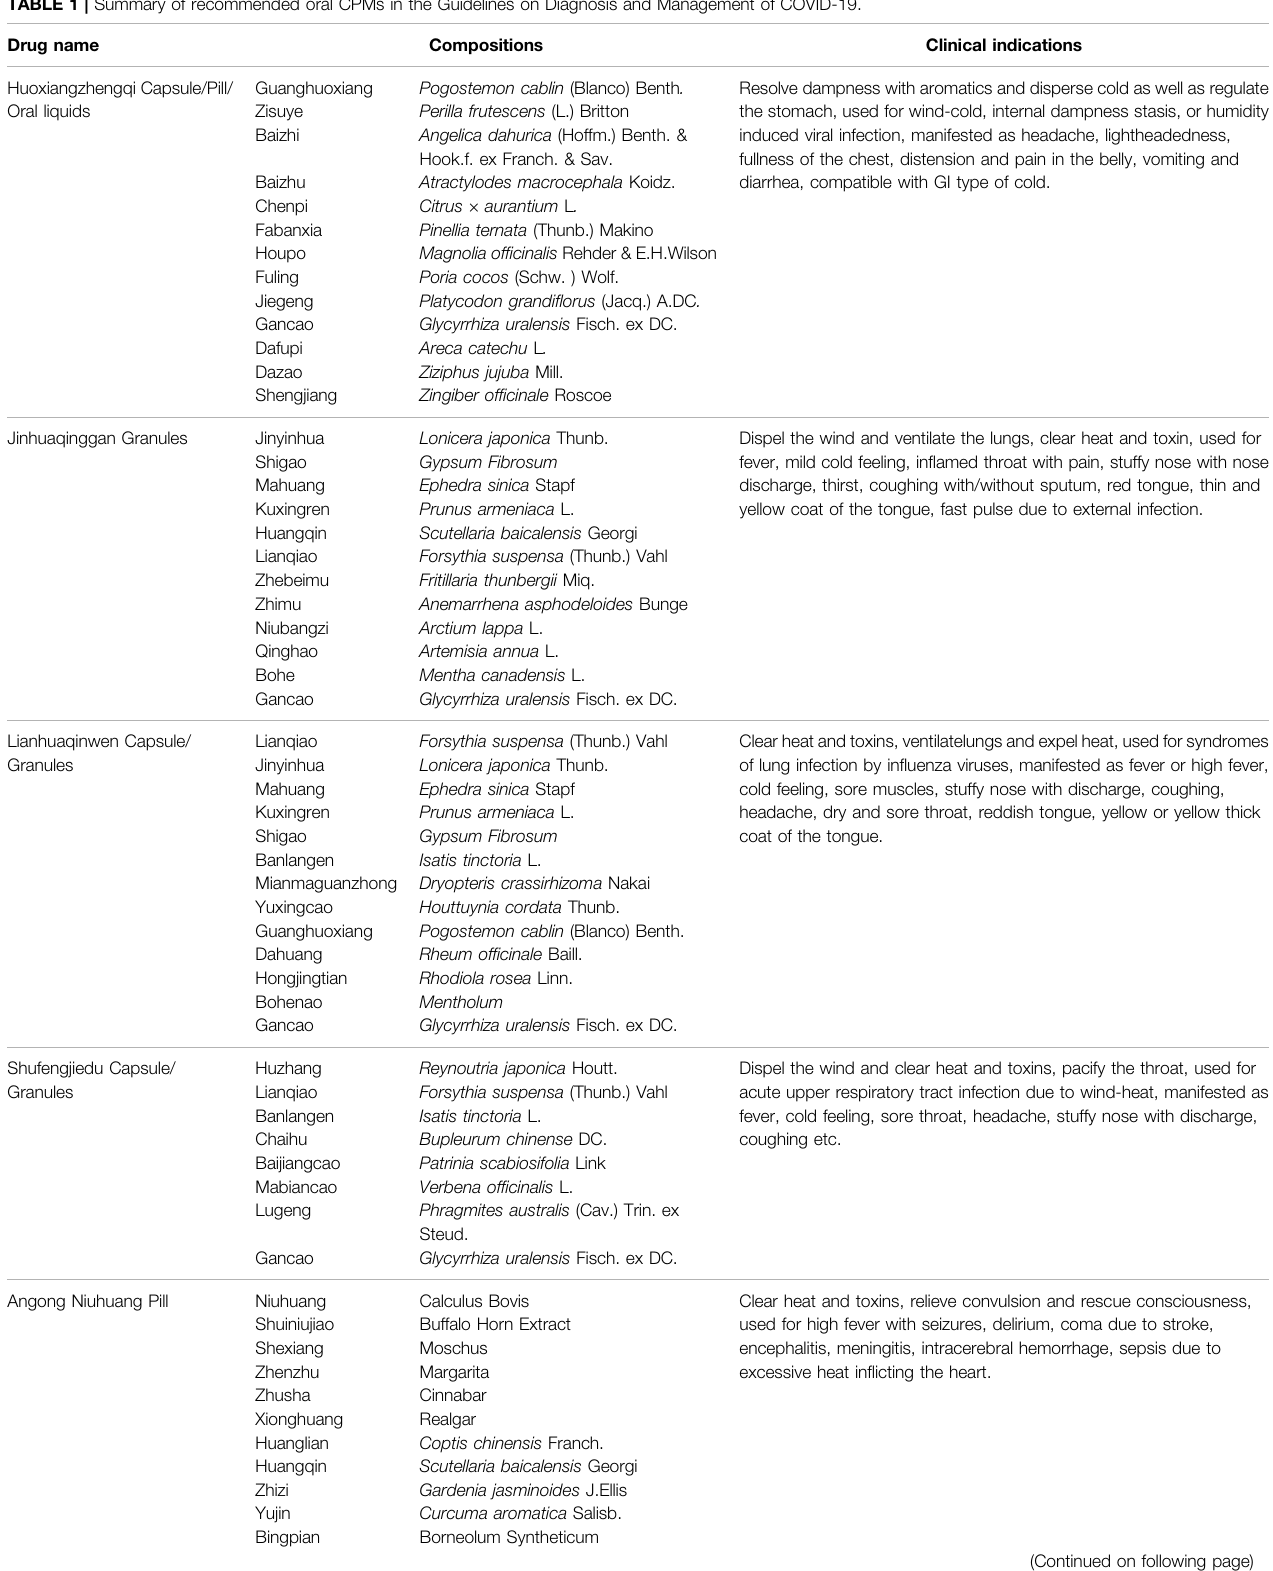
TABLE 1 | Summary of recommended oral CPMs in the Guidelines on Diagnosis and Management of COVID-19. Drug